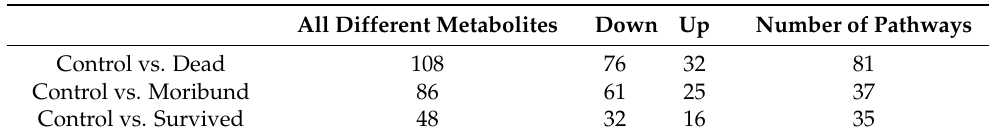
Table 1. Number of significantly different metabolites down-regulated (Down) and up-regulated (Up) in different comparisons examined in Macrobrachium nipponense . All Different Metabolites Down Up Number of Pathways Control vs. Dead Control vs. Moribund Control vs. Survived